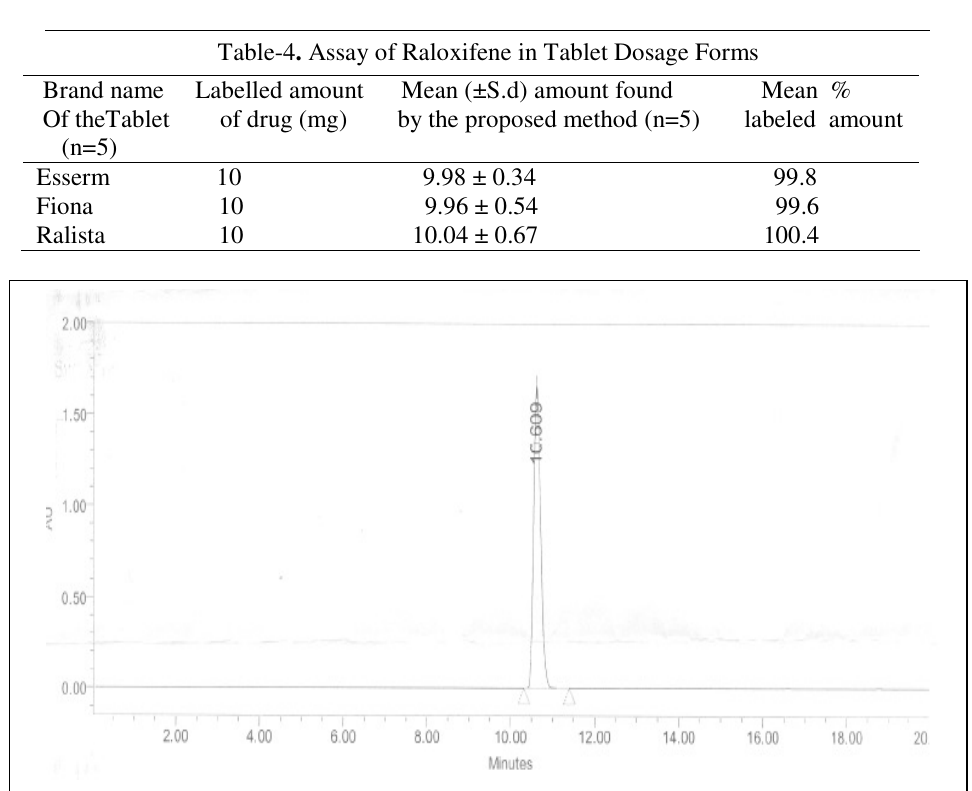
Table-3 . Intra and Inter Day Precision of the Proposed Method